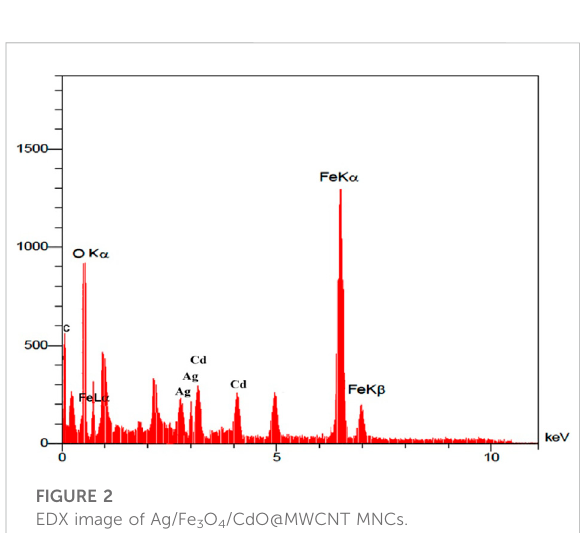
FIGURE 2 EDX image of Ag/Fe 3 O 4 /CdO@MWCNT